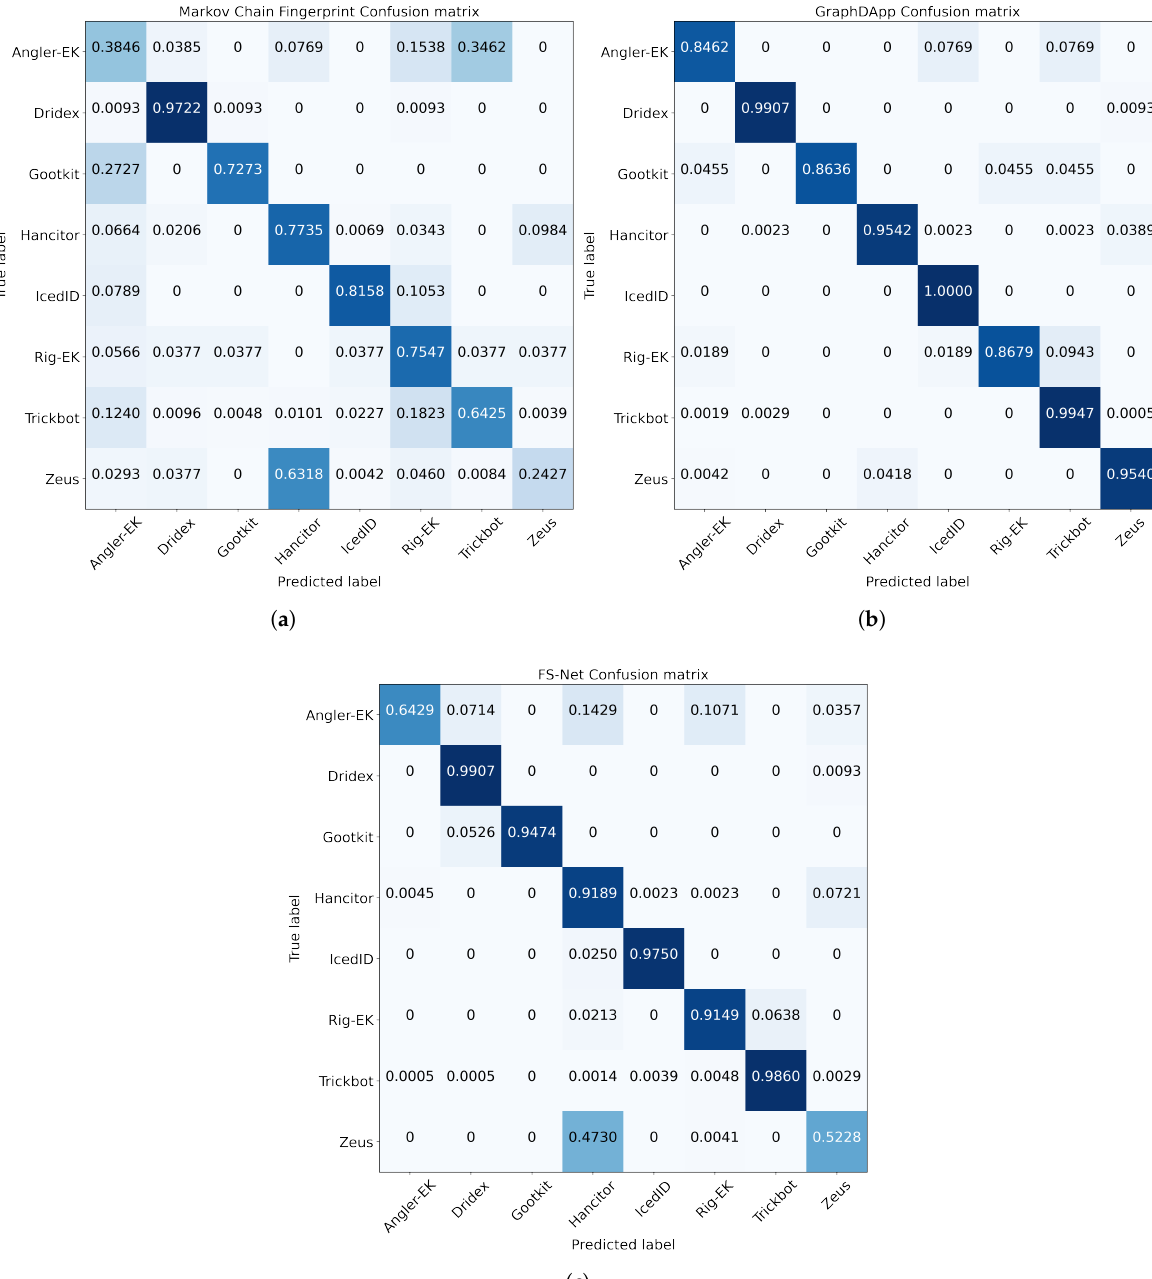
Figure 5. Confusion matrices of classification results using ( a ) Markov chain fingerprinting with maximum likelihood classifier, ( b ) traffic interaction graph with fully connected layer classifier (GraphDApp), and ( c ) embedding vector with FS-Net with balanced train